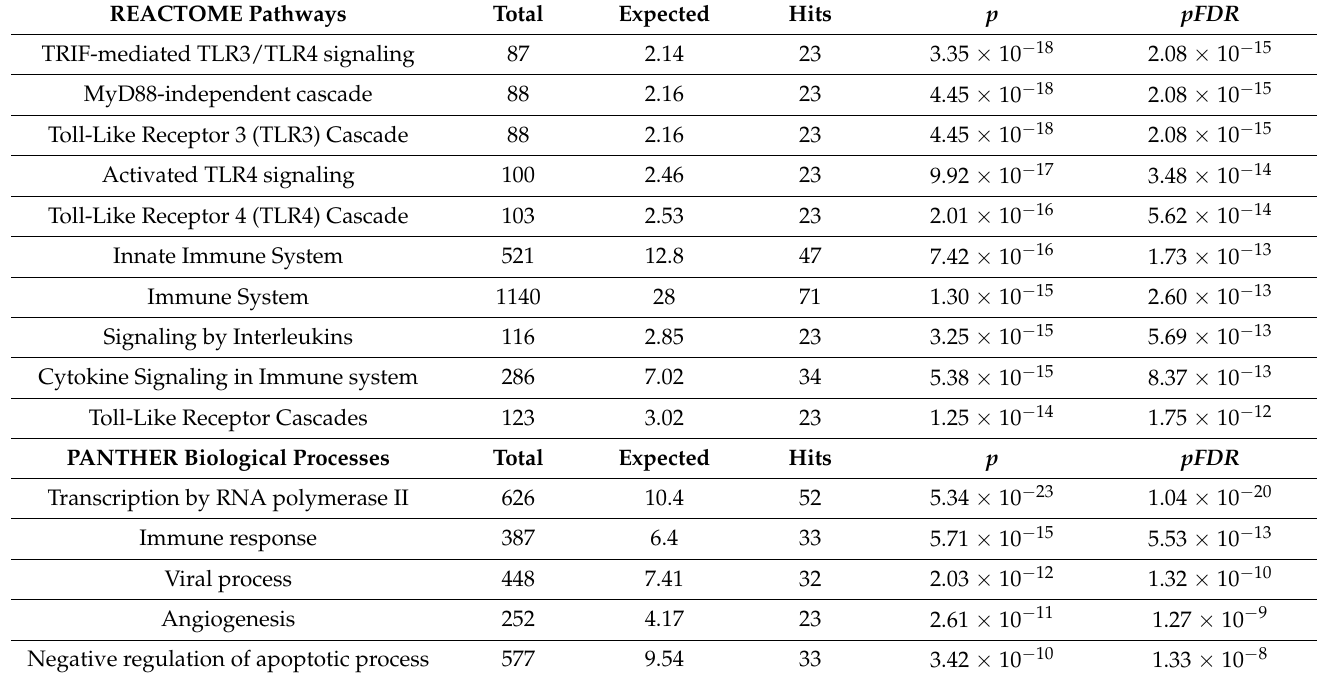
Table 7. REACTOME pathways and PANTHER biological processes statistically over-represented in the differentially expressed proteins of major dysmood